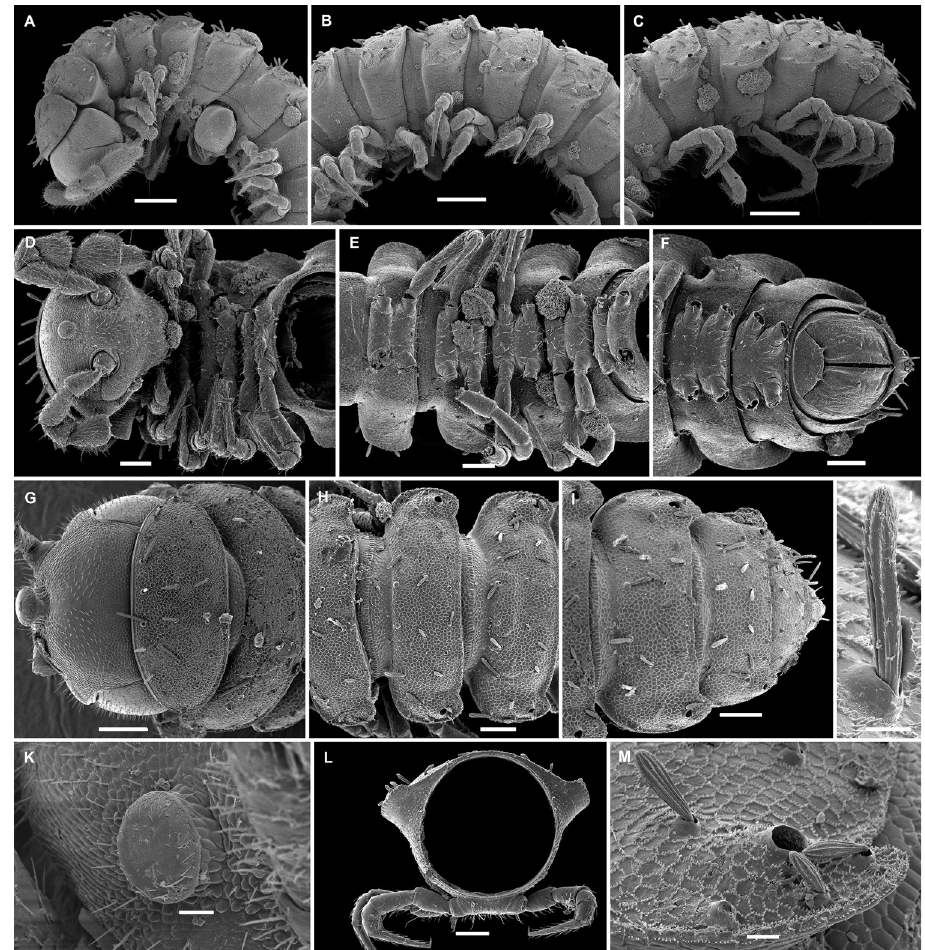
Figure 3. Hemisphaeroparia zamakoe sp. n., SEM micrographs of ♂ paratype A, D, G anterior part of body, lateral, ventral and dorsal views, respectively B, E, H midbody segments, lateral, ventral and dorsal views, respectively C, F, I posterior part of body, lateral, ventral and dorsal views, respectively J tergal seta, lateral view K epicranial tubercle, subdorsal view L midbody segment, caudal view M midbody parater- gum, lateral view. Scale bars: 0.1 mm ( A–I, L ), 0.05 mm ( K, M ), 0.01 mm ( J